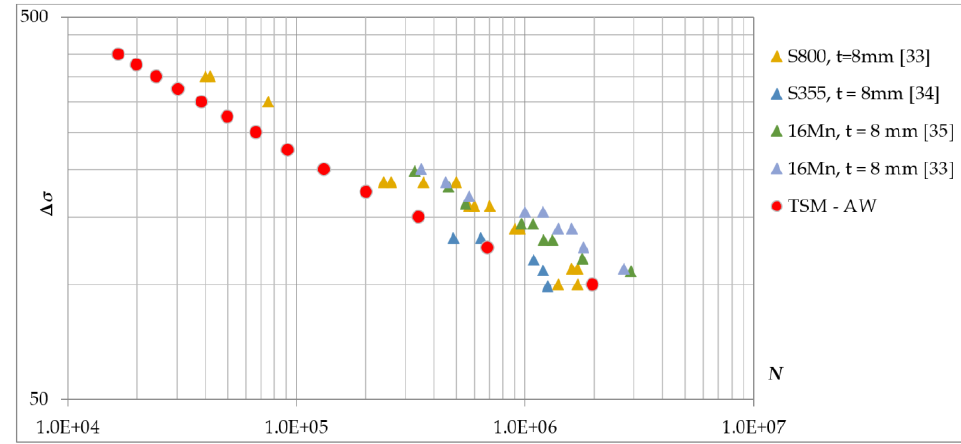
Figure 9. Results of calculated fatigue life for AW condition.